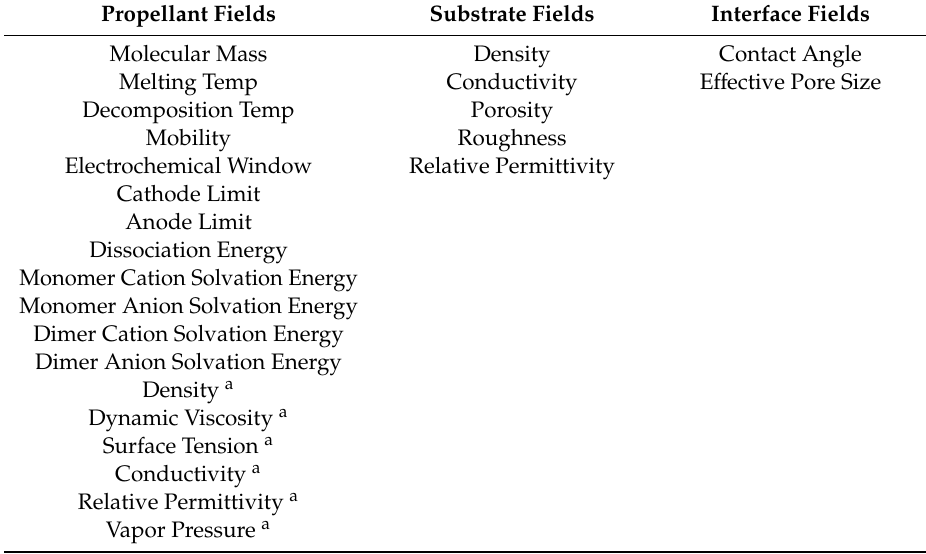
Table 3. Database property